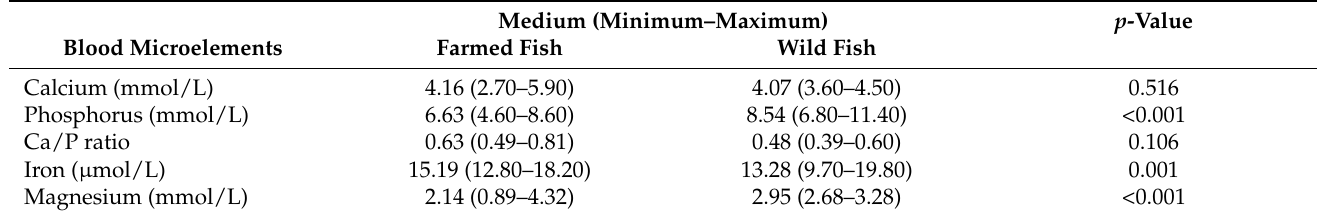
Table 2. Blood microelements in rainbow trout ( Oncorhynchus mykiss ) from fresh water.